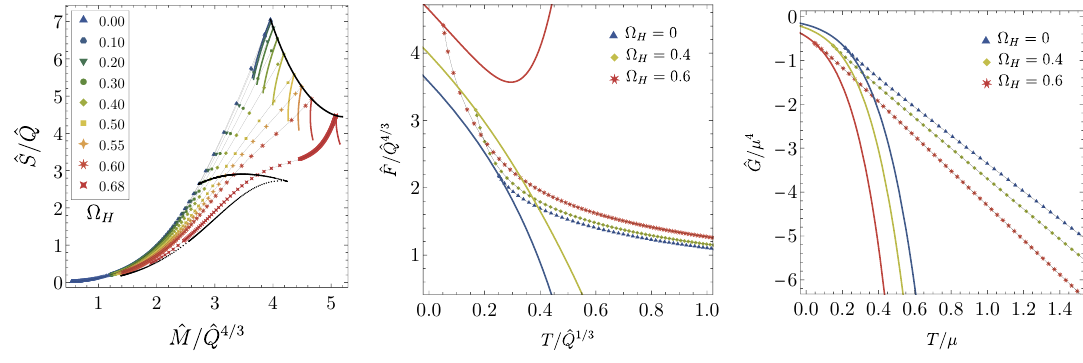
Figure 19 . Left : rotating hairy brane entropy density as a function of the mass density in the microcanonical ensemble, for di(cid:11)erent values of (cid:10) H (data points in rainbow). Solid black line shows the onset of the instability, and solid rainbow lines are the corresponding solutions without hair. The black data points show two hairy black hole families, one of constant " H = 3 : 5, and one of constant (cid:10) H = 0 : 72. Middle : hairy black brane free energy density as a function of temperature in canonical ensemble, for di(cid:11)erent values of (cid:10) H (see the inset legend). The solid lines show the corresponding solutions without hair. Right : the free energy density in the grand-canonical ensemble, against the